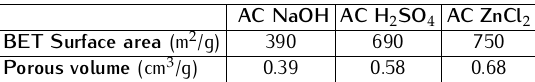
Table 1. BETsurfaceareasandporousvolumeofobtainedactivated carbons.